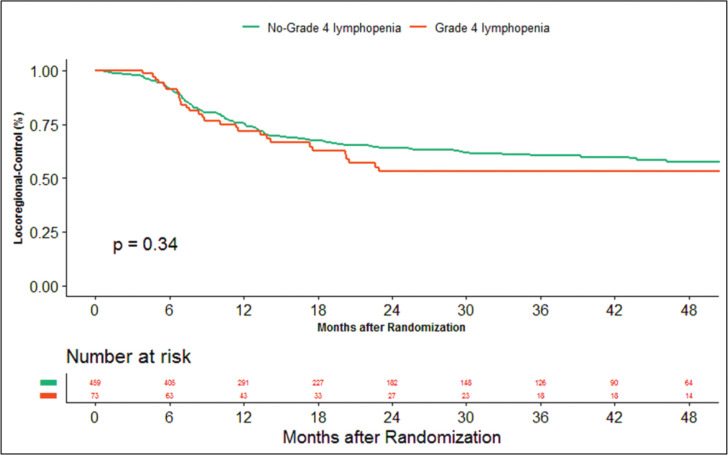
Kaplan–Meier curve showing loco-regional control in grade 4 (severe) and non-grade 4 lymphopenia (non-severe).